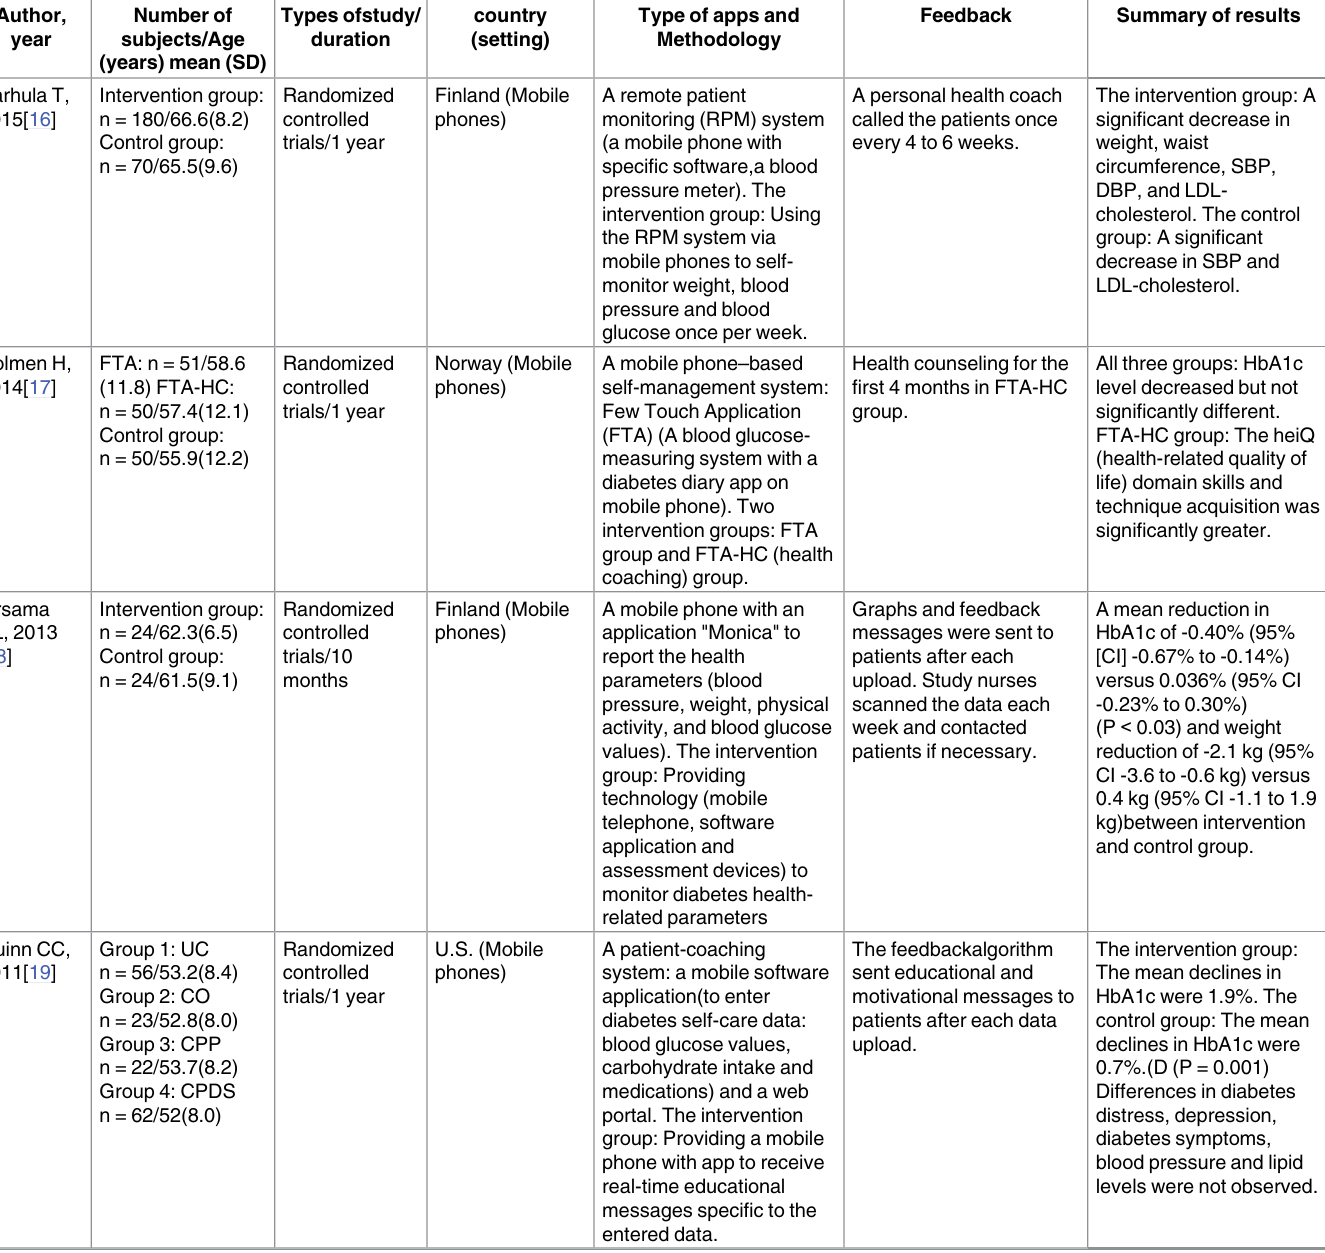
Table 1. Informations of selected